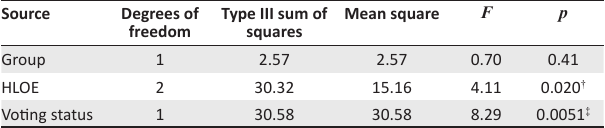
TABLE 2: Determination of the association between Modified Cognitive Assessment Tool for Voting overall score and group, highest level of education and voting status.